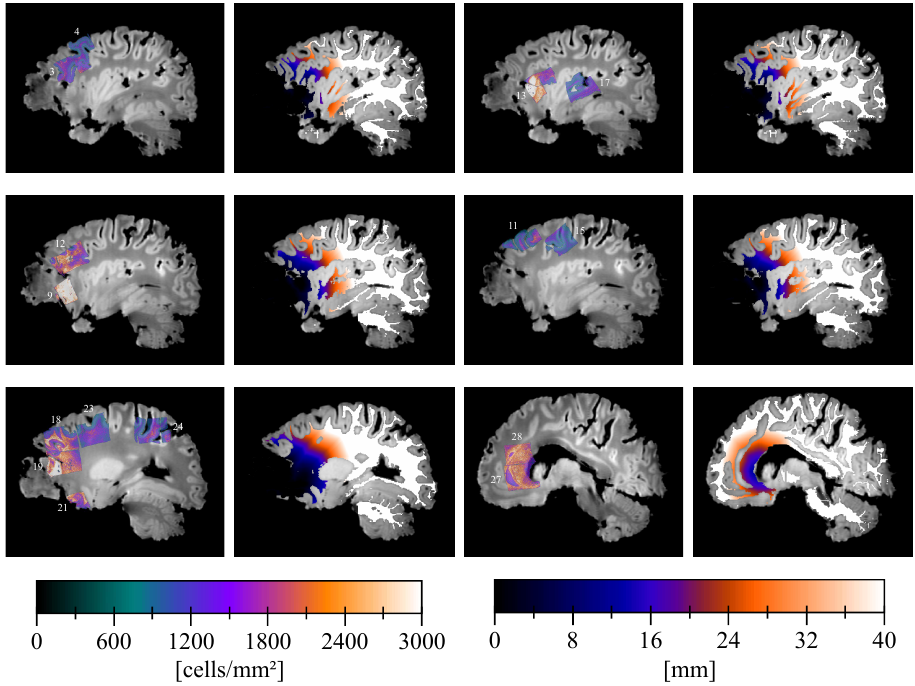
Figure 4. Example of registered cell density maps with their slide number (see Table A1) ( 1st and 3rd columns ) and corresponding slices of the geodesic distance map to the tumor core ( 2nd and 4th columns ) superimposed to the ex vivo T1